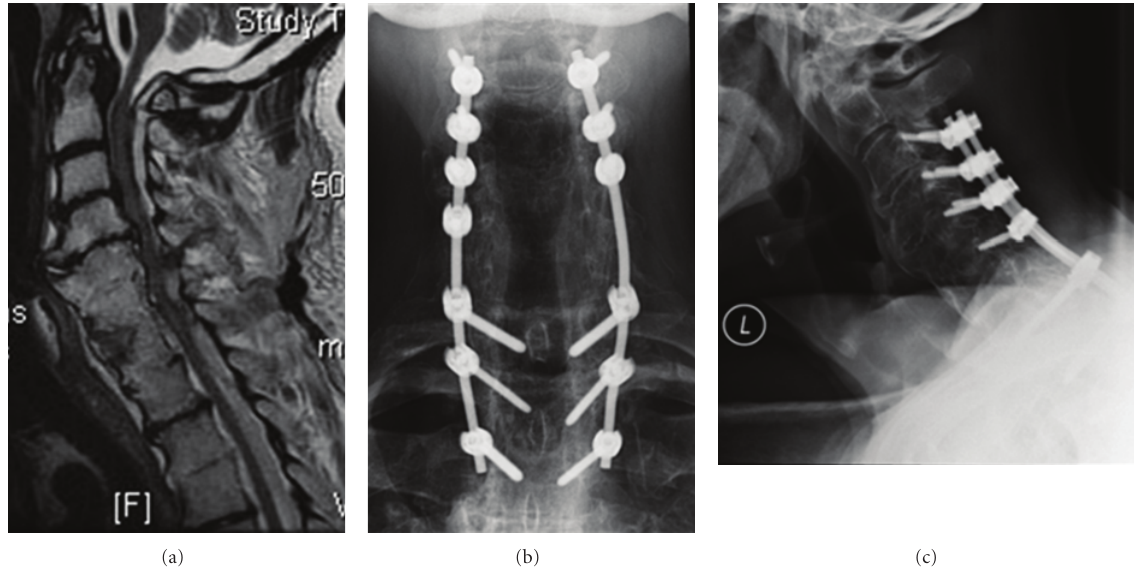
Figure 5: (a) Sagittal MRI of a patient with severe multilevel spondylosis and stenosis. (b-c) Anteroposterior (b) and lateral (c) radiographs of same patient after multilevel laminectomy and fusion. Note that distal fixation was achieved with pedicle screws which have increased pullout resistance compared with lateral mass